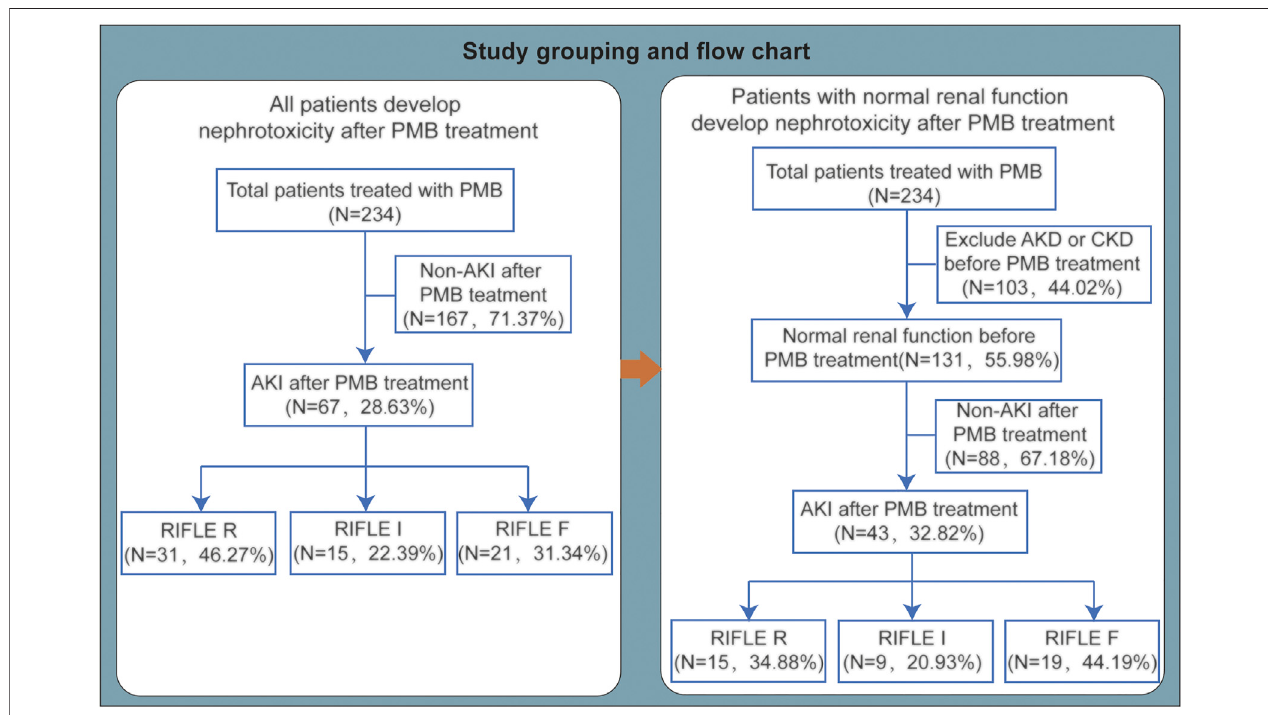
FIGURE 1 | Study grouping and fl ow chart. PMB, polymyxin B; AKI, acute kidney injury; AKD, acute kidney disease; CKD, chronic kidney